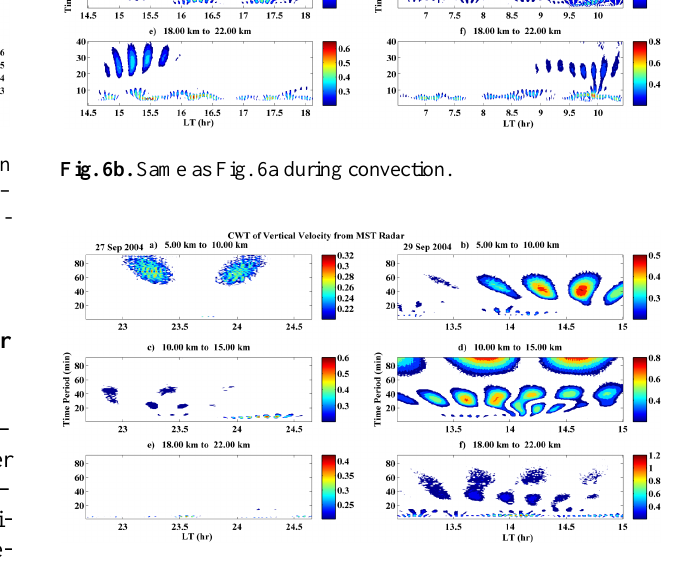
Figure 6C. Same as Figure 6A and 6B after convection. 716 Fig. 6c. Same as Fig. 6a and b after